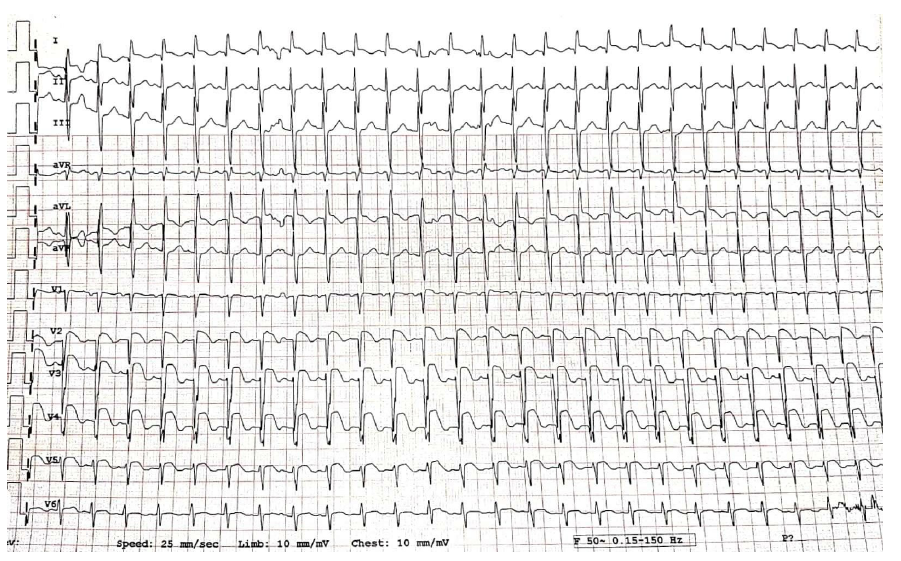
Figure 1. Electrocardiogram at admission.